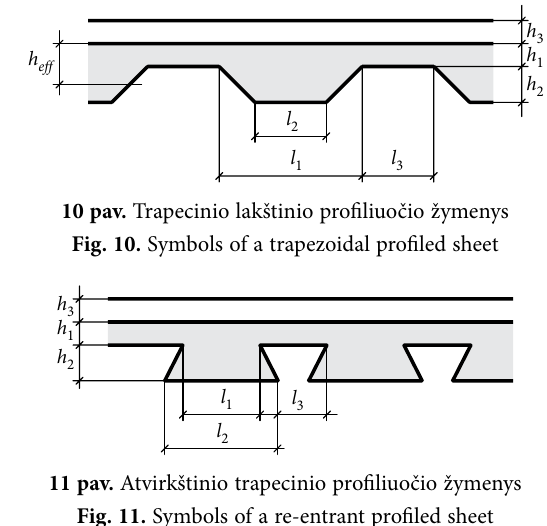
Fig. 11. Symbols of a re-entrant profiled sheet